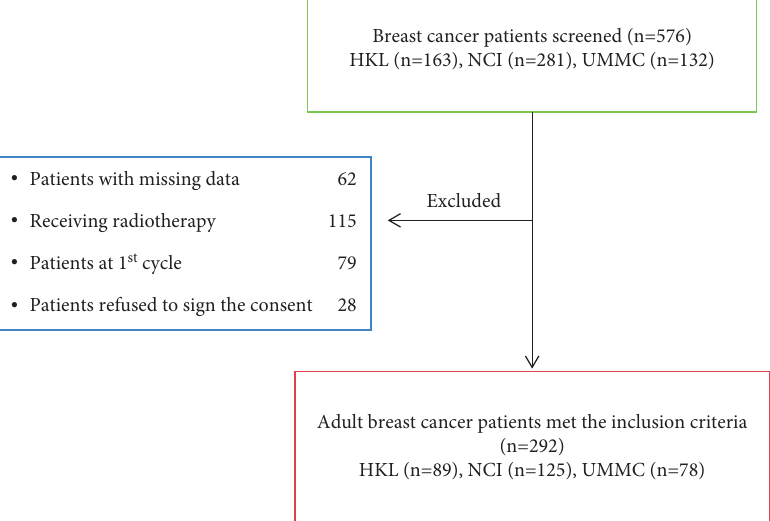
Figure 1: Adult patients with breast cancer screened during study